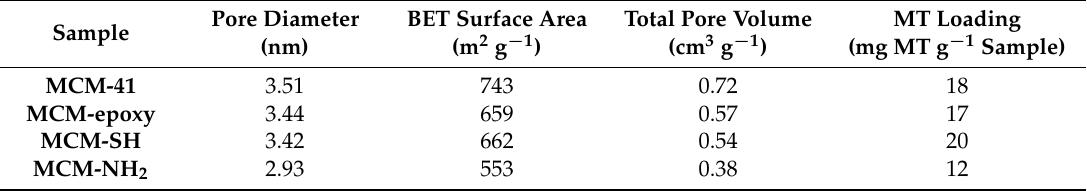
Figure 1. ( a ) X-ray diffraction pattern of MCM-41, ( b ) Transmission electron micrographs of MCM-41 in the (100) direction, ( c ) TEM measurement of the silica wall thickness and pore size. Table 1. Physical data of the silica-based materials.